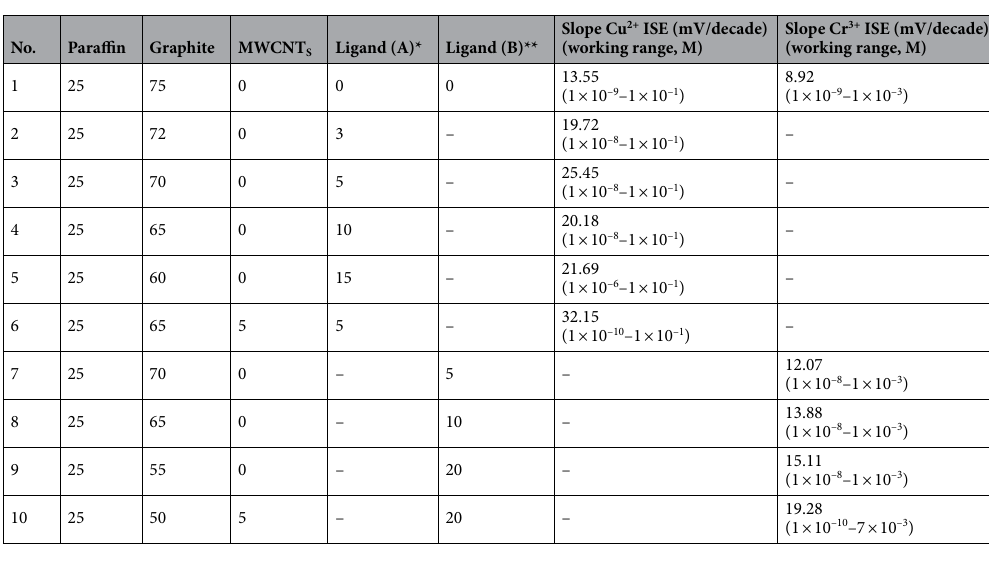
Table 1. Optimizing the carbon paste composition. *A: 4-methylcoumarin-7-yloxy-N-phenyl acetamide. **B: 4-methylcoumarin-7-yloxy-N-4-nitrophenyl acetamide.